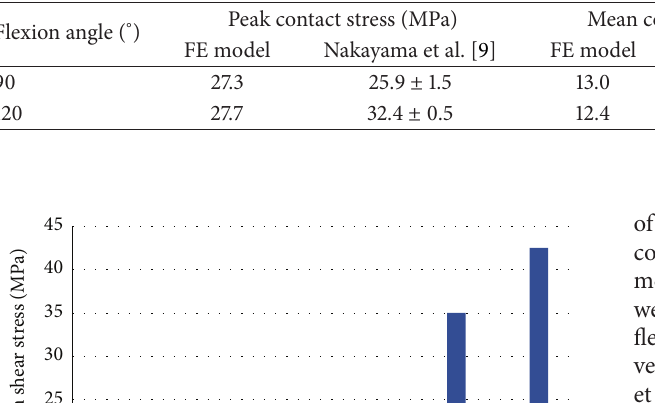
Table 1: Peak contact stress, mean contact stress, and contact area with neutral position at 90 ∘ and 120 ∘ of flexion angles.